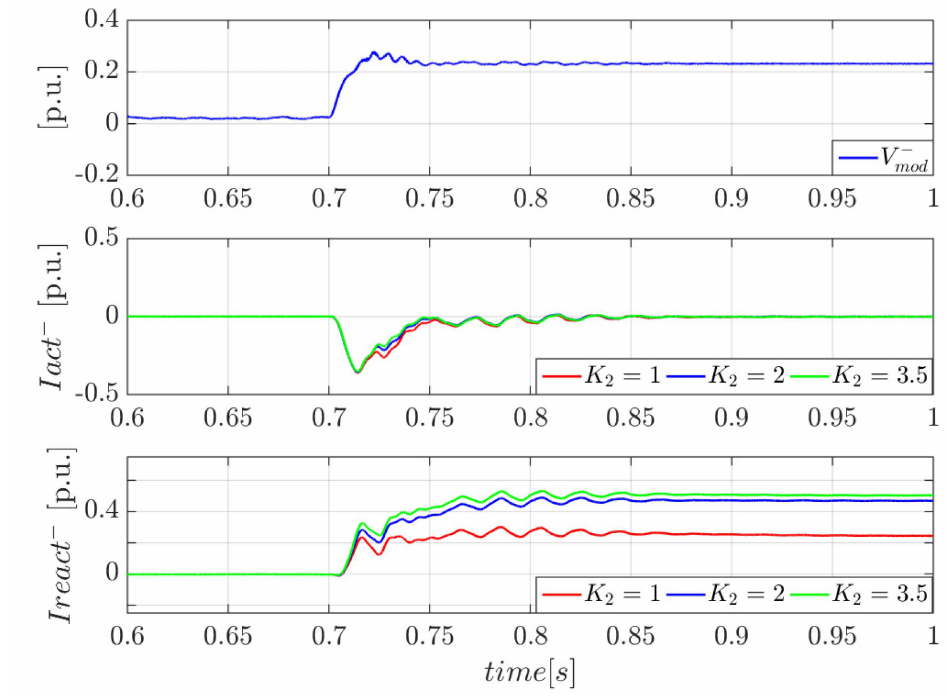
Figure 26. GFM converter negative sequence voltage and currents during the unbalanced fault for K and K different 2 1